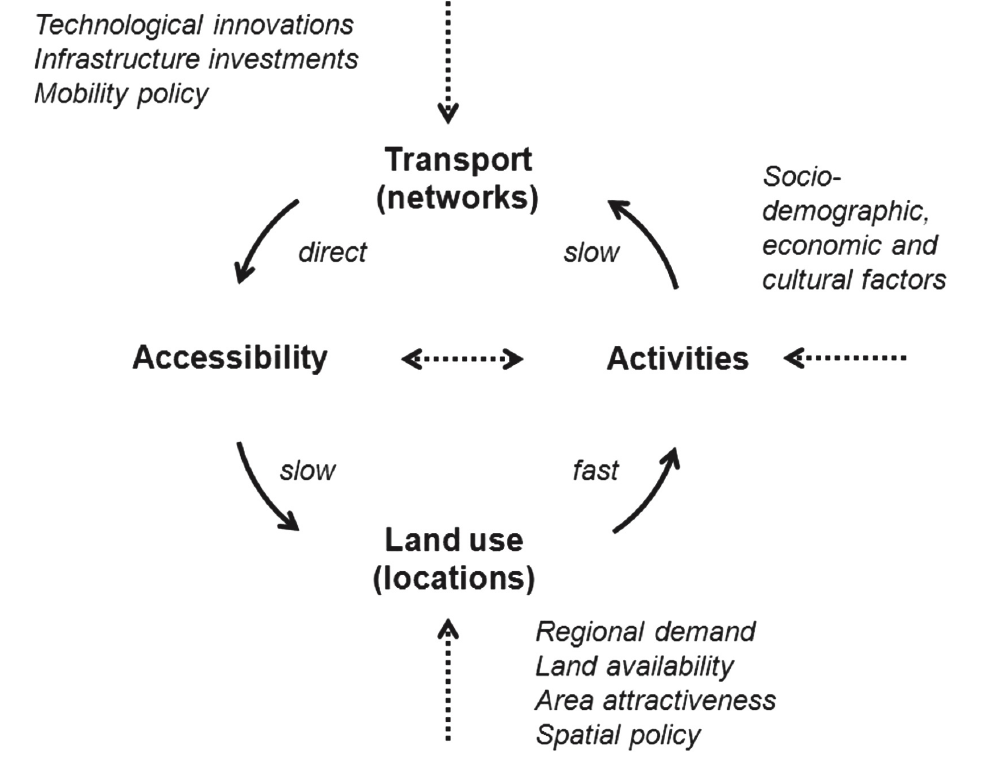
Figure 1. Transport and land use feedback